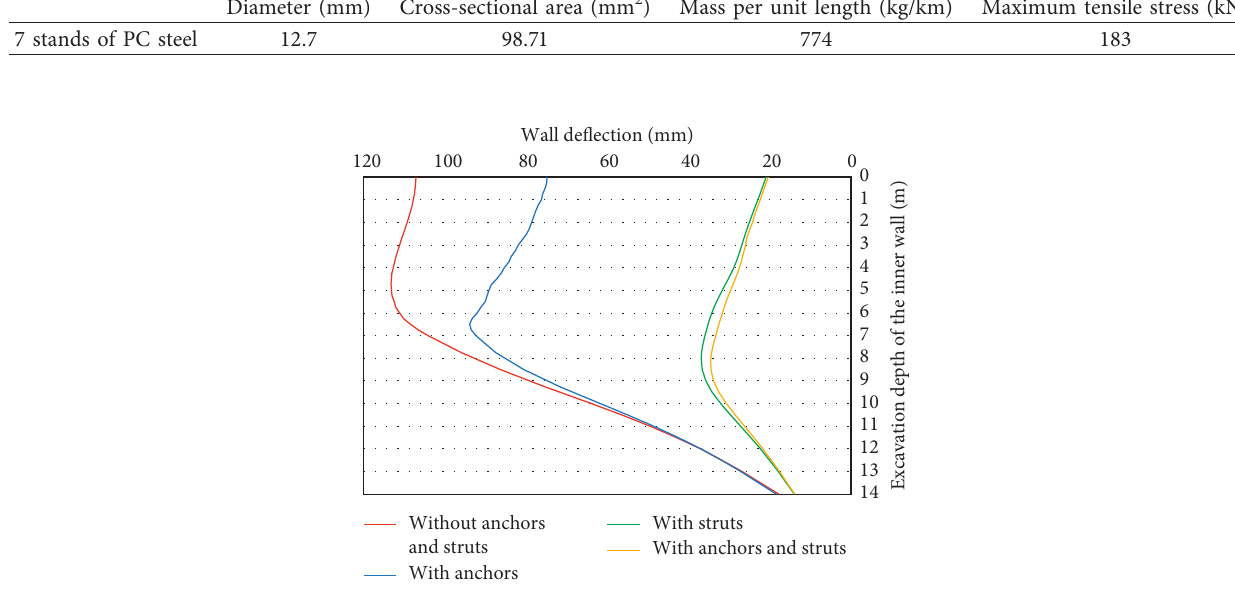
Figure 5: Comparison of inner wall deflection.